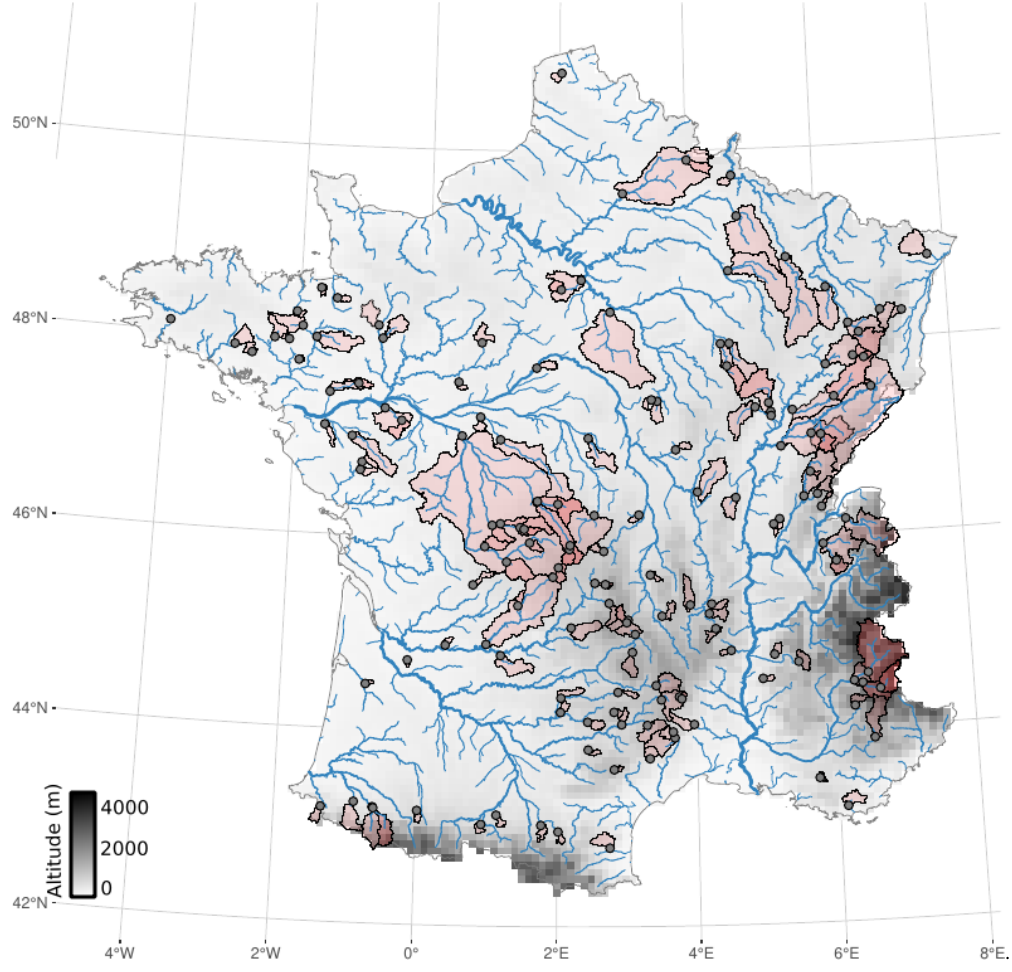
Figure 1. Location of stream gauges (gray dots), corresponding watersheds (pale red; Brigode et al., 2020), hydrographic network (blue lines; Pella et al., 2012), and orography in Safran data set (grayscale; Vidal et al.,